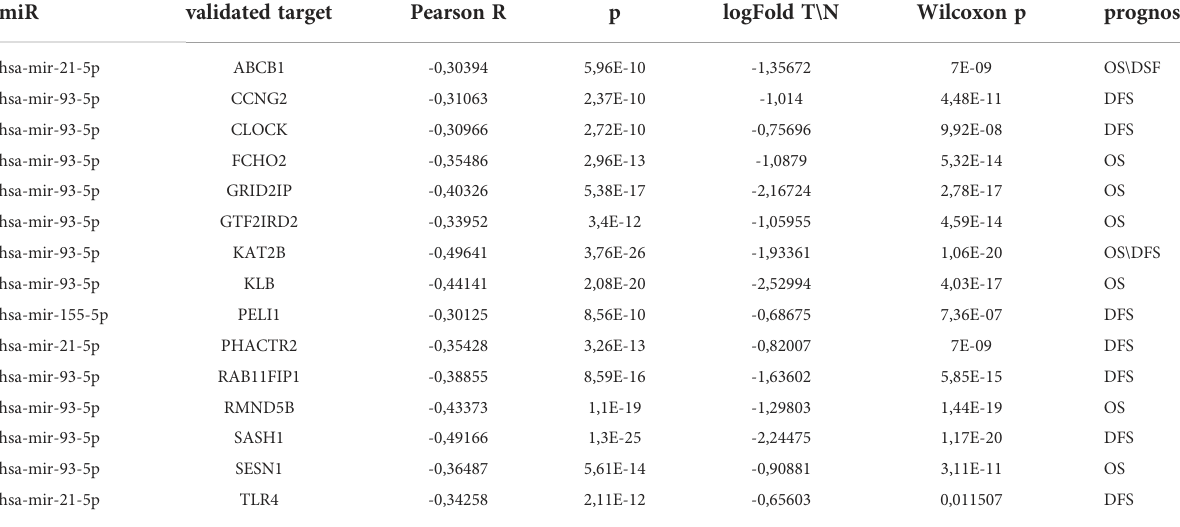
TABLE 2 miR-21-5p, miR-93-5p, and miR-155-5p validated targets, expression levels and OS/DFS signi fi